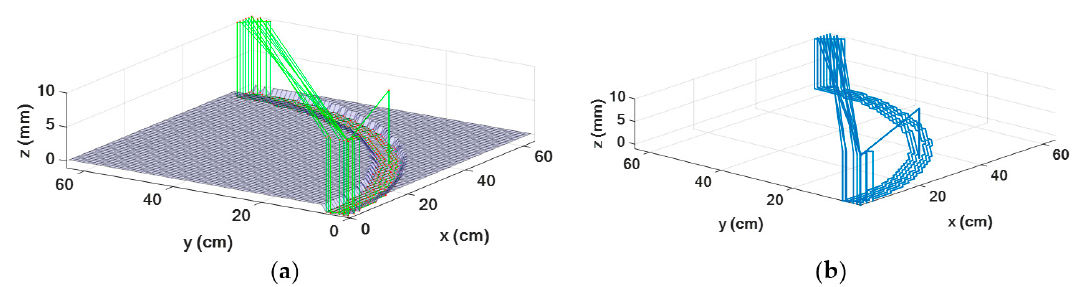
Figure 12. Image processing technique based milling operation simulation. ( a ) Hypersurface visualization and process definition for milling operation of circular path. ( b ) Tool-path planning and plotting.